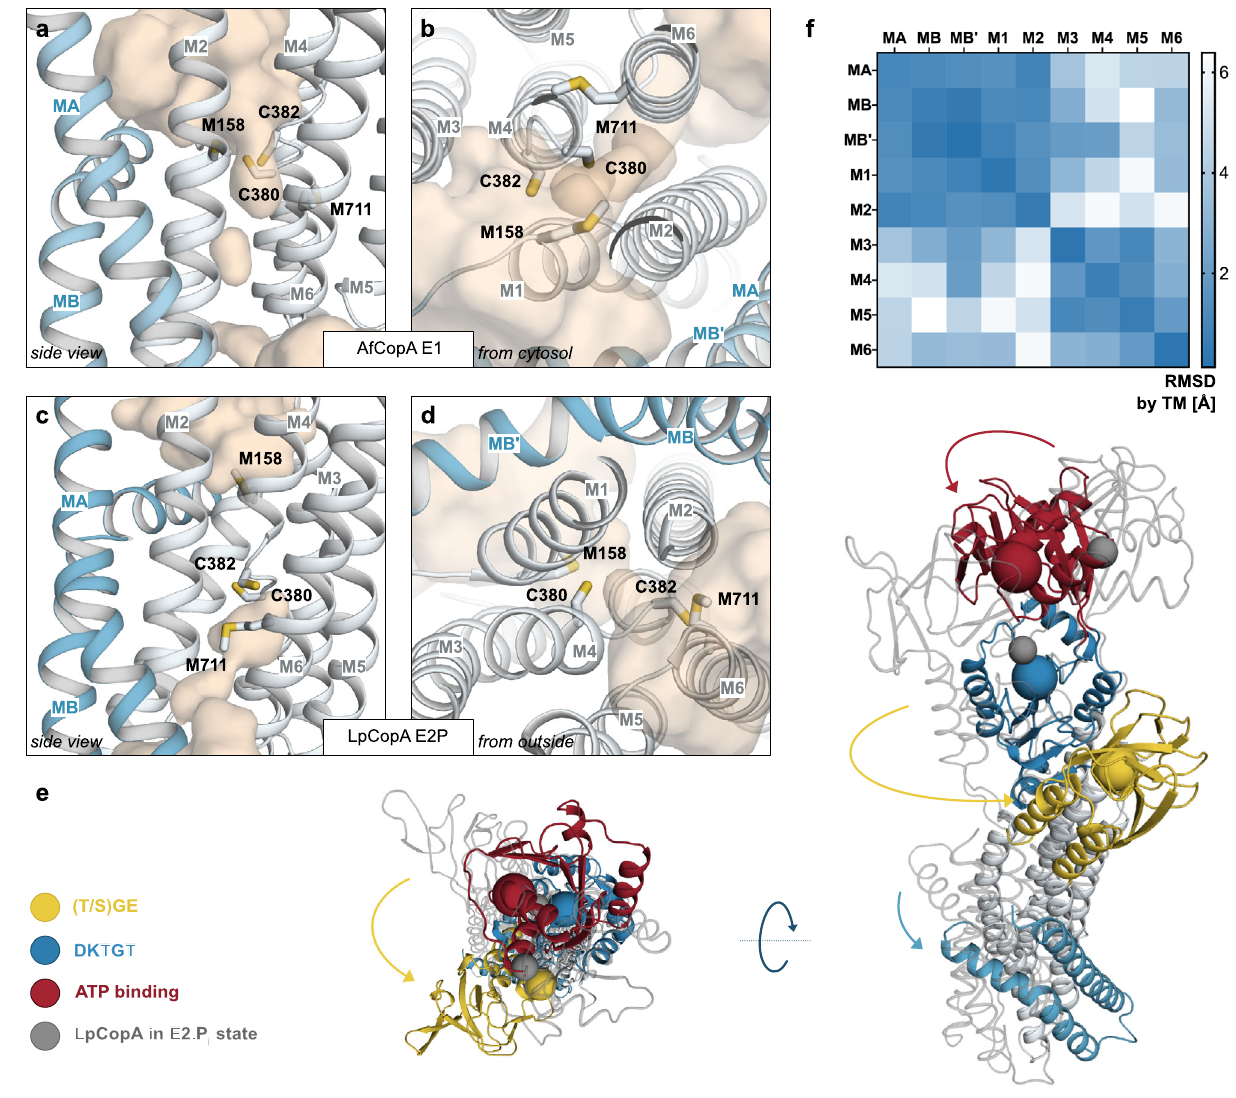
Fig.2|TheE2 → E1transition. M-domainsolvent-accessibleregions(wheat)of a , b theheredeterminedAfCopAE1structureand c , d theE2PstateofLpCopA(PDB-ID 4BBJ with the residues numbered as AfCopA). In the AfCopA E1 structure, the conserved CPC motif in M4 is exposed to the cytosol, whereas the LpCopA E2 conformationisoutward-open. e AlignmentoftheAfCopAE1statetotheP-domain of LpCopA (PDB-ID 3RFU) illustrates conformational changes during the E2.P i →